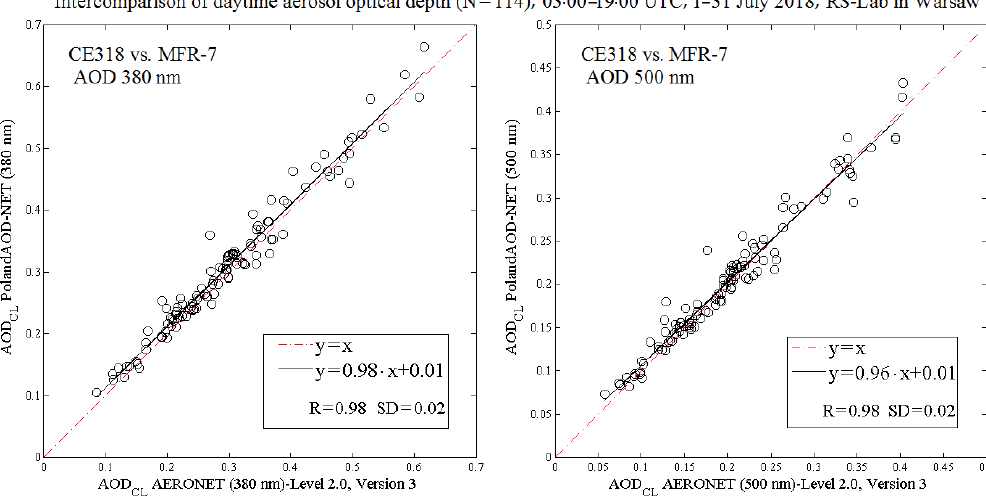
Figure 3. Intercomparison of hourly averaged clear-sky daytime aerosol optical depth measured within the atmospheric column (AOD CL ) with the CE318 instrument at the AERONET site in Warsaw (Version 3 Level 2.0 data) and the MFR-7 shadowband radiometer at the PolandAOD-NET site in Warsaw (Level 1.5 data). Note the high agreement obtained for both wavelengths for a month (July 2018) of co- located measurements (instruments at a distance of 3m and at the same altitude) at the RS-Lab in Warsaw. The AOD CL at 415nm from the MFR-7 was scaled to 380nm using the Ångström power law.